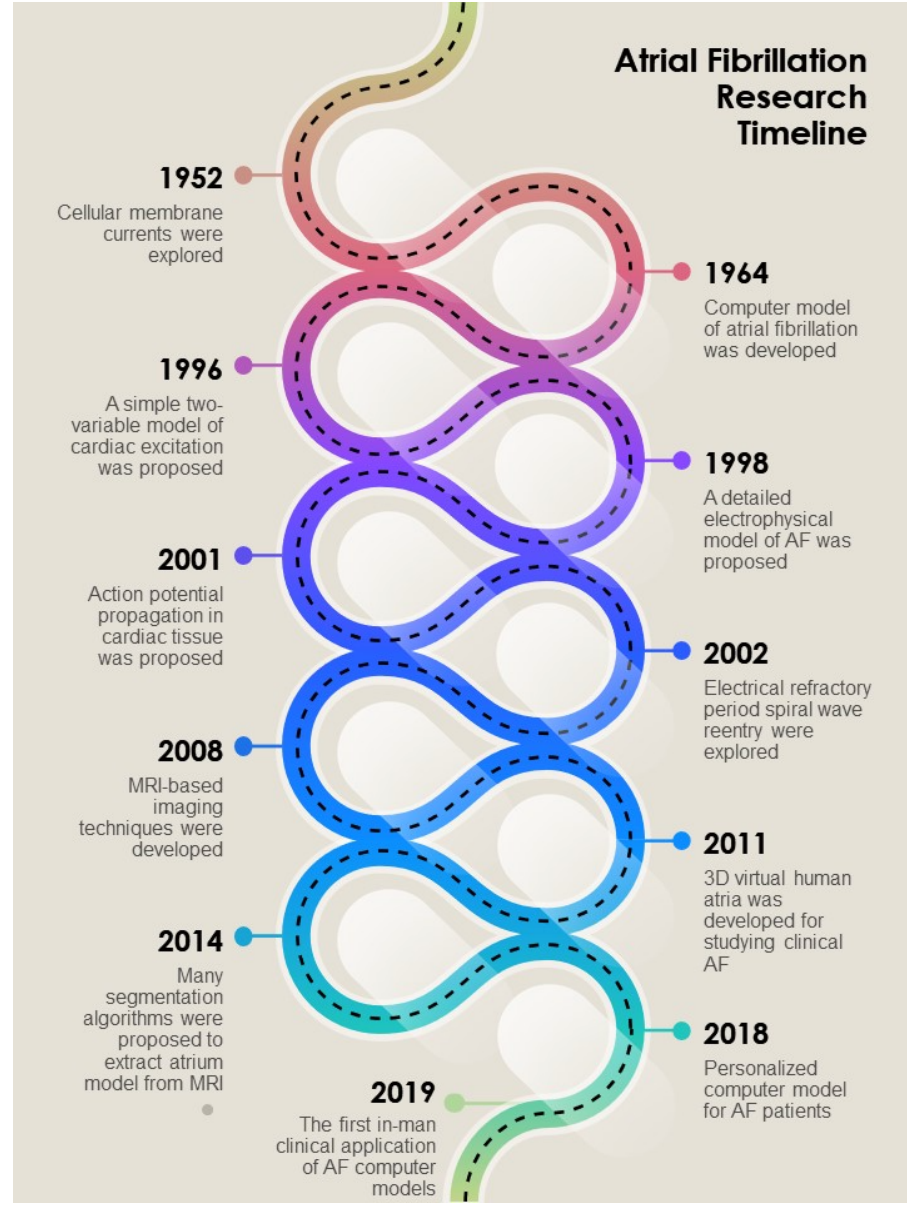
Figure 2. Atrial fibrillation research